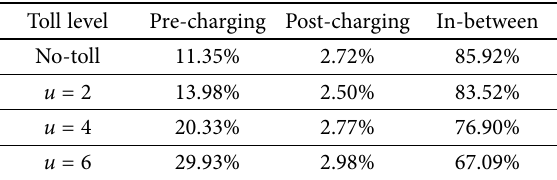
Table 2. Percentages of demand departing before and after